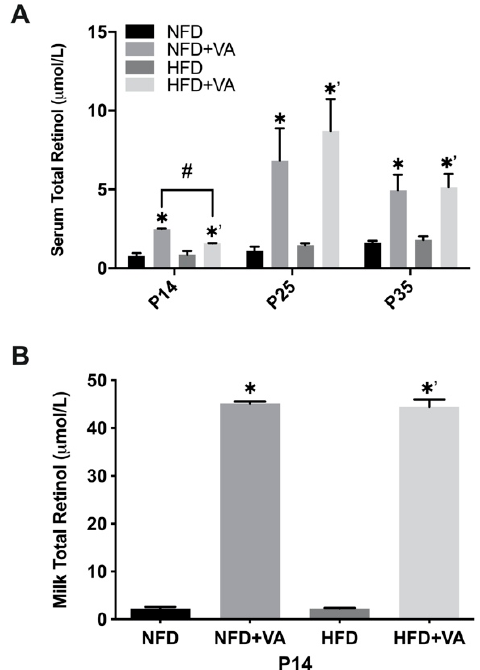
Figure 1. Concentrations of total retinol in the serum ( A ) of rat pups and in milk ( B ). Bars show mean ± SEM, n = 4 or 3 per group. Significant difference, p < 0.05, between NFD and NFD+VA was indicated by *, between HFD and HFD+VA by * ’ , and between NFD and HFD or between NFD+VA and HFD+VA by #. P14, postnatal day 14; P25, postnatal day 25; P35, postnatal day 35; NFD, normal fat diet; HFD, high fat diet; VA, vitamin A.